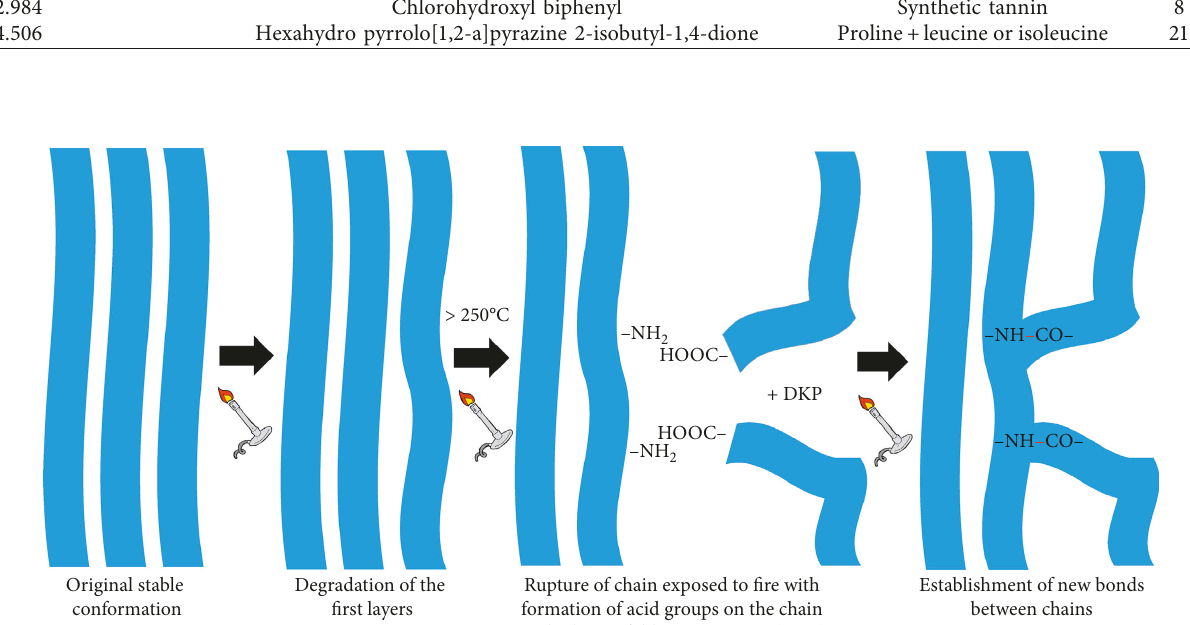
Figure 7: Scheme of the possible mechanism for the high resistance of a wet-white leather shavings board against the hot-gun perforation test.